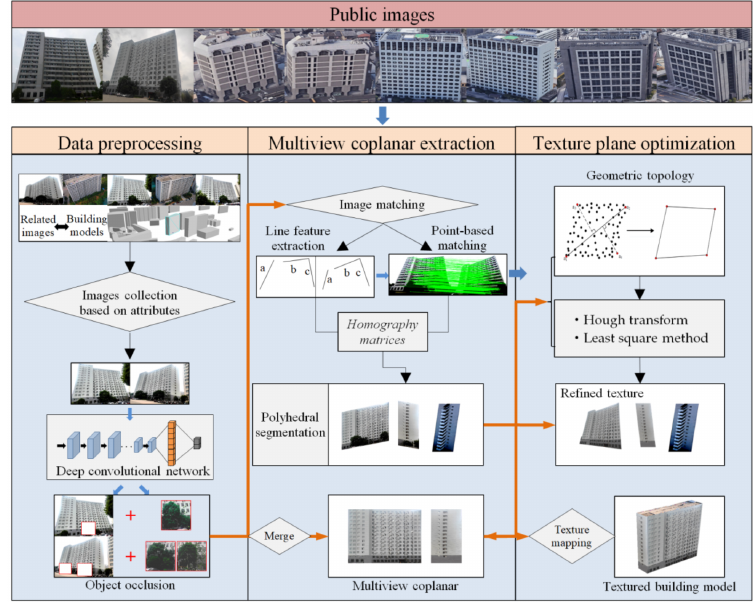
Figure 2. Workflow of the proposed